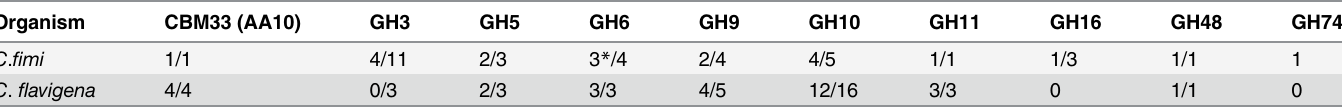
Table 2. Detected cellulase and xylanase enzymes compared to the prediction. Organism